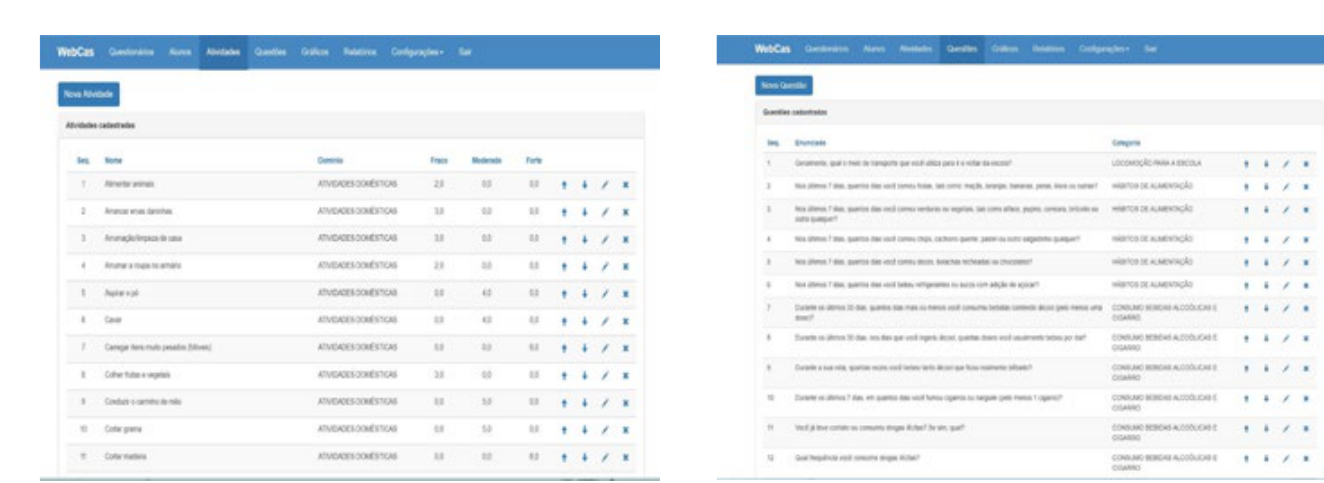
FIGURE 3 - WebCas activity intensity rating screen. FIGURE 4 - The eight WebCas activity domains